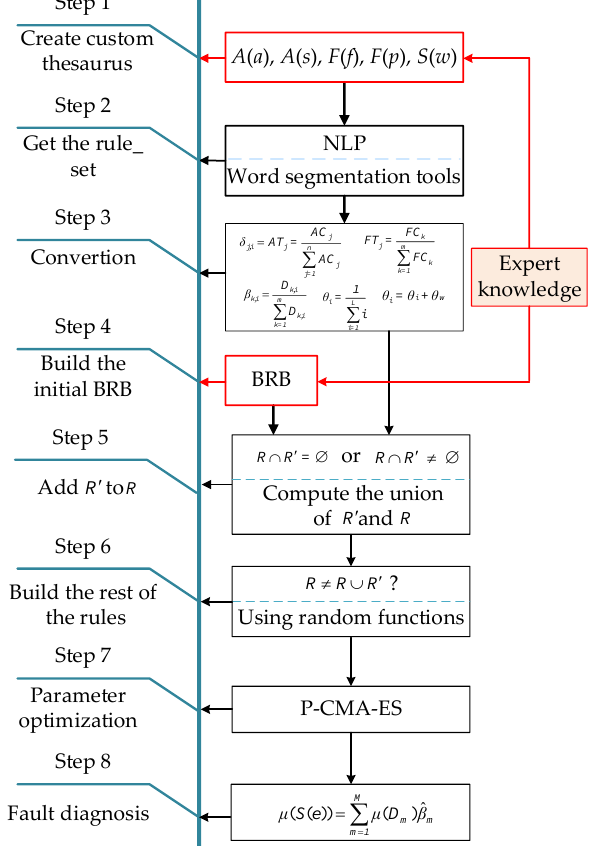
Figure 8. BRB construction model.